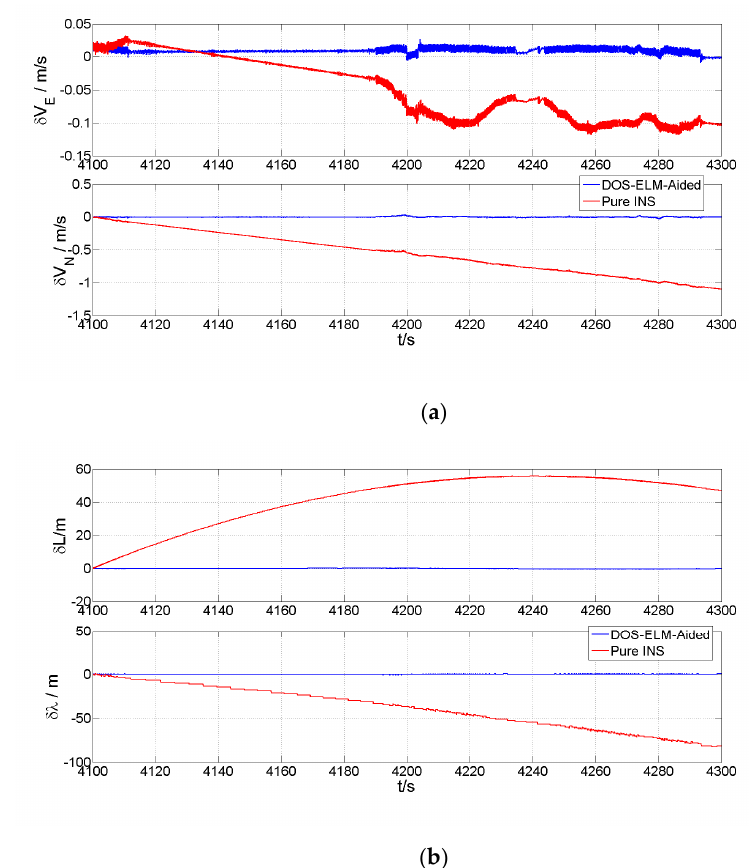
Figure 9. Comparison of speed/position errors between DOS-ELM-aided and pure INS methods during GPS outage #2 in the vehicle-mounted experiment. ( a ) Eastern and northern speed errors of DOS-ELM-aided and pure INS methods during GPS outage #2 in the vehicle-mounted experiment. ( b ) Eastern and northern position errors of DOS-ELM-aided and pure INS methods during GPS outage #2 in the vehicle-mounted experiment.